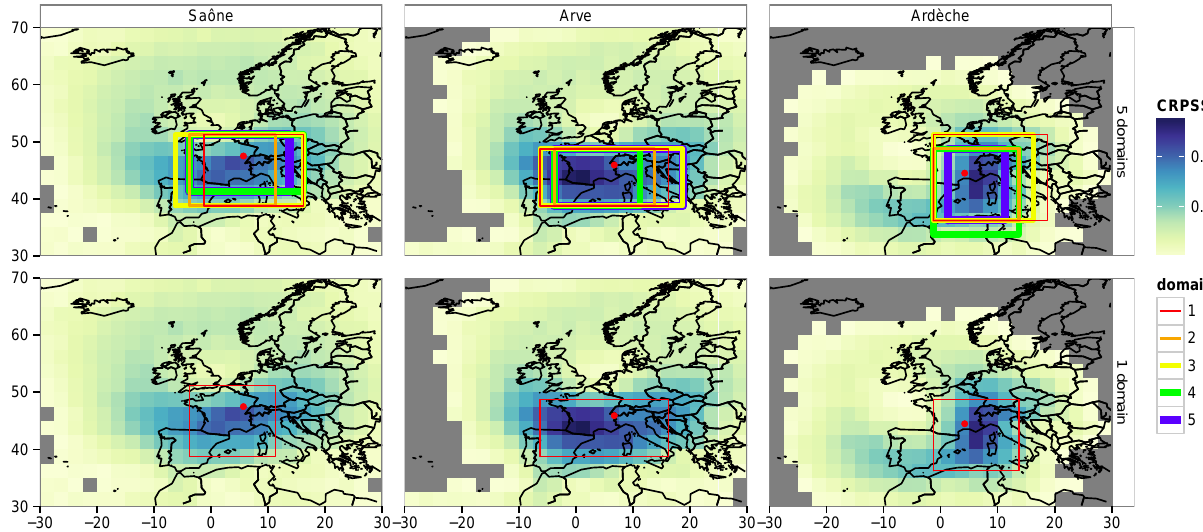
Fig. 9. Optimised predictor domains for three case study zones using the extended optimisation method with five domains (first row) or the basic optimisation method with one domain (second row). The relevance maps for each zone are shown with a colour scale underneath the predictor domains.